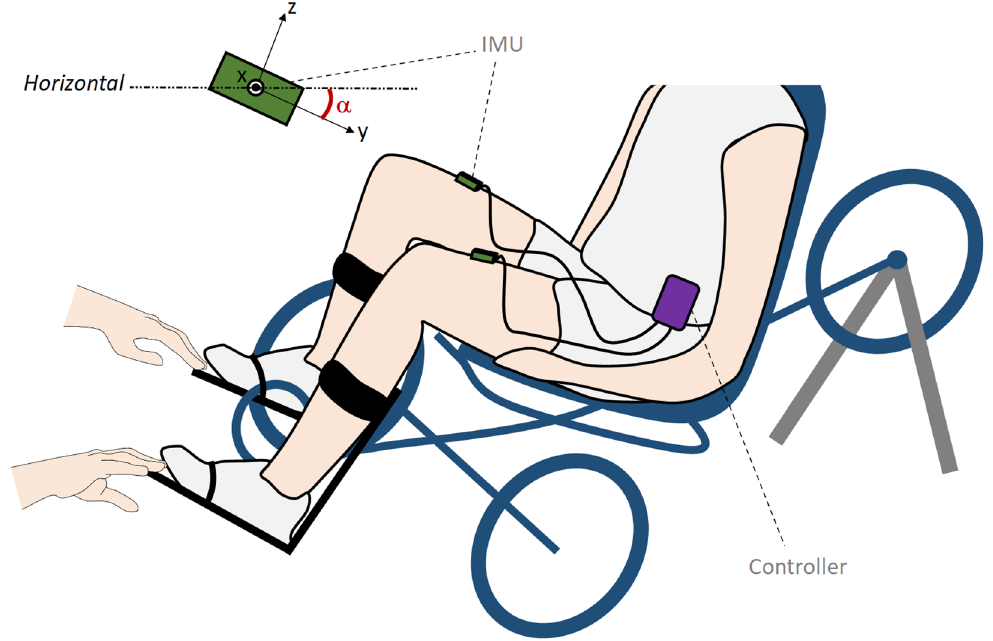
Figure 1. Experimental setup for cycling movement analysis. Participants were equipped with the IMUSEF system composed of two inertial measurement units, one located on each thigh and connected to a controller (Raspberry Pi 3B© embedded single board computer) used to acquire the inertial measurement data. The IMU’s axes are represented in the top left with the thigh angle inclination being the α angle (gyroscope roll axis).